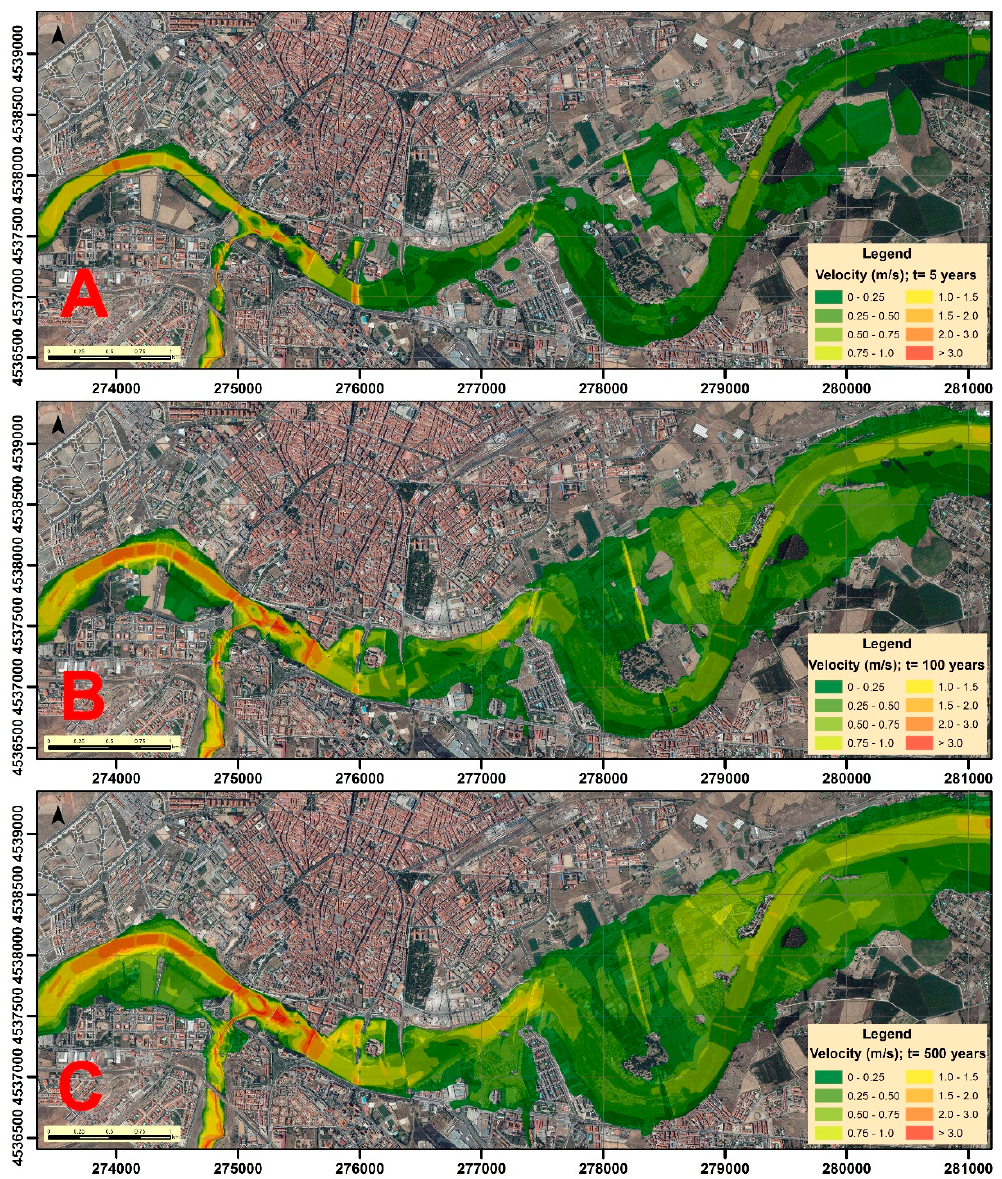
Figure 3. Water velocity (m/s) in the different scenarios: ( A ) T = 5 years; ( B ) T = 100 years; and ( C ) T = 500 years.